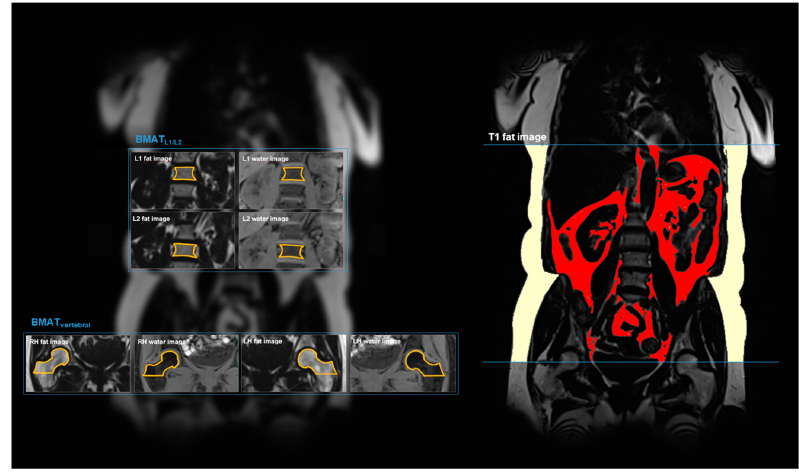
Figure 1. Illustration of the fat measurements in 3 Tesla whole-body magnetic resonance imaging (MRI). For all derived fat depots, a coronal 2-point Dixon T1-weighted sequence was used. The left panel shows the measurements of vertebral and femoral bone marrow adipose tissue content (BMATL1 / L2 and BMATfemoral, respectively) by placing a region of interest in the fat and water image and calculating a ratio. The right panel shows the segmentation of subcutaneous adipose tissue (SAT; light yellow) and visceral adipose tissue (VAT; red) of an a 61-year-old male (body mass index (BMI) 29.7 kg / m 2